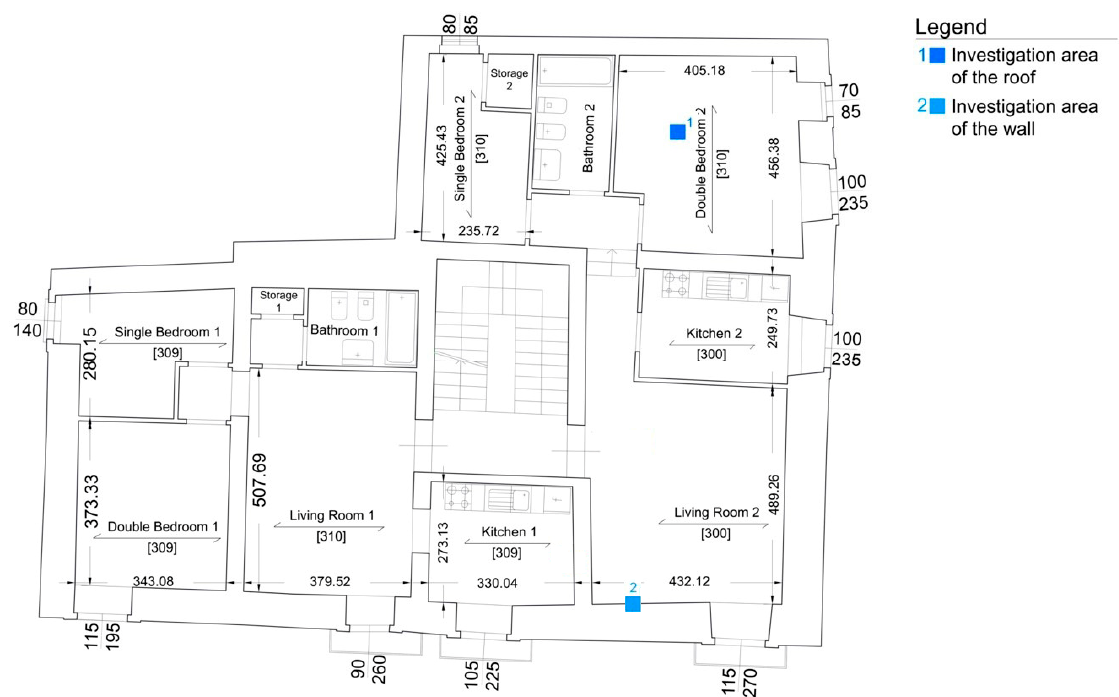
Figure 6. Investigation areas on the roof ( 1 ) and the wall ( 2 ).